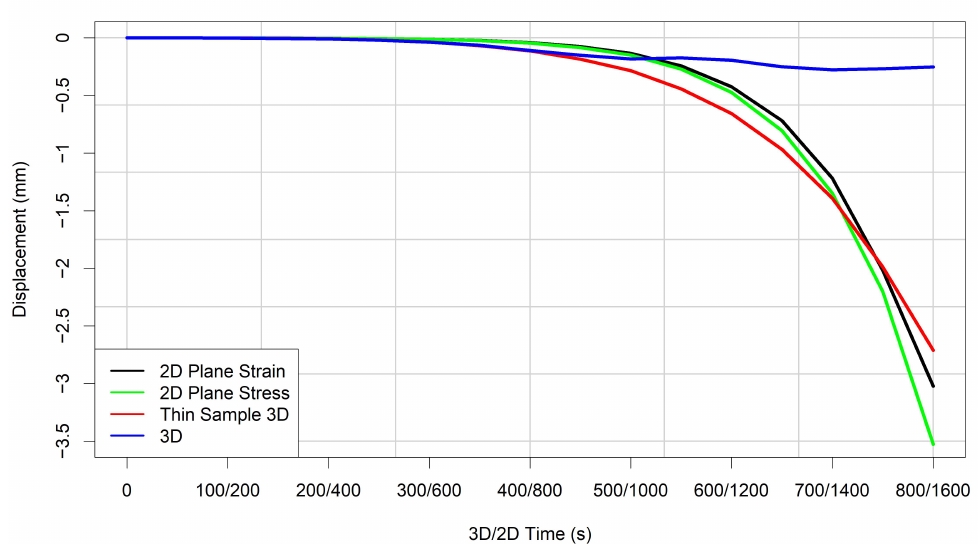
Figure 4. Total displacements observed at the tip of dendrites grown using different modelling assumptions. Different time scales are used for 3D/2D comparison as the constrained diffusion in 2D approximately halves the growth